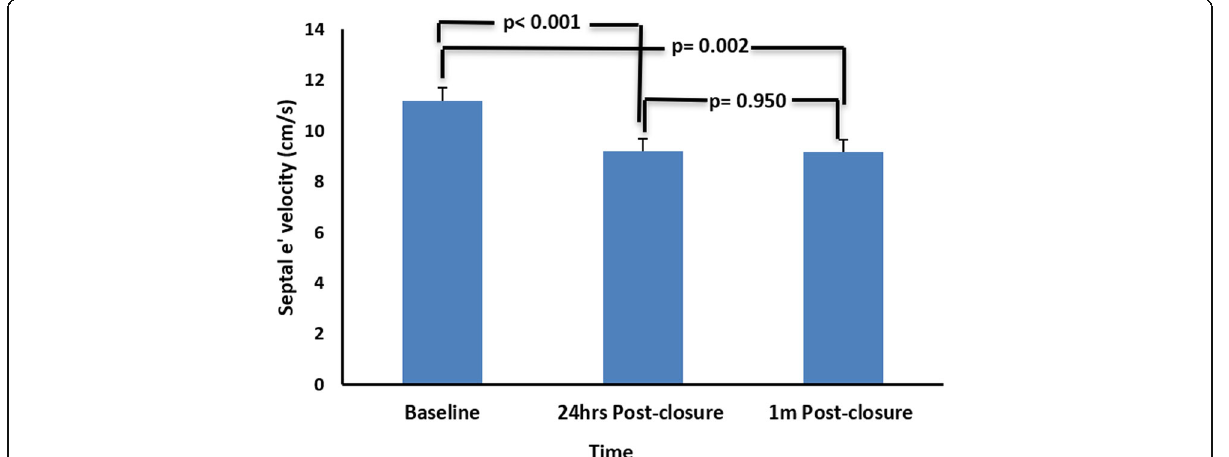
Fig. 1 Changes in left ventricular diastolic function before and after transcatheter ASD device closure of the total ASD study group. Significant reduction in septal ( e ′ ) 24 h and 1 month after ASD device closure with insignificant changes between 24 h and 1 month later. ASD, atrial septal defect; LV, left ventricle; Septal e ′ , early diastolic velocity of septal mitral annulus